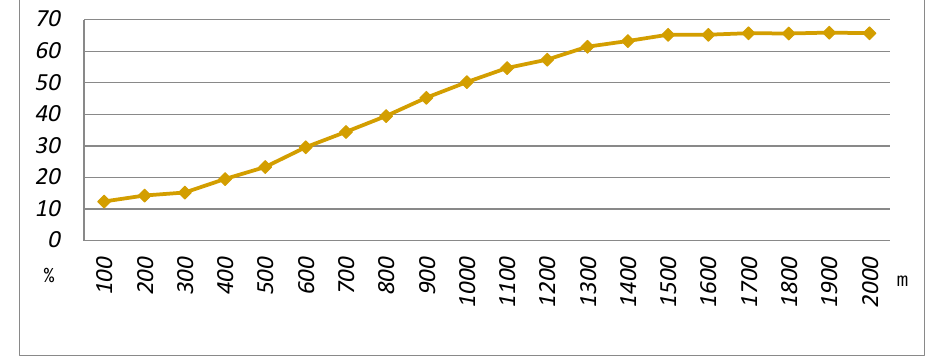
Figure6. The coincidence rate increases with the range of